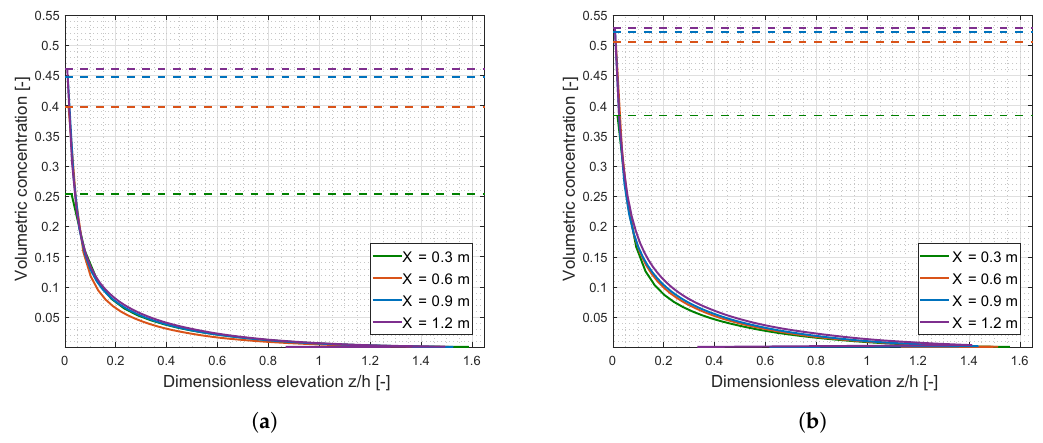
Figure 12. Composite plot of numerical concentration profiles spaced by a distance of 0.3 m: ( a ) 64 ◦ breach face (Run 3); ( b ) 77 ◦ breach face (Run 6); horizontal dashed lines refer to the concentration maximum.